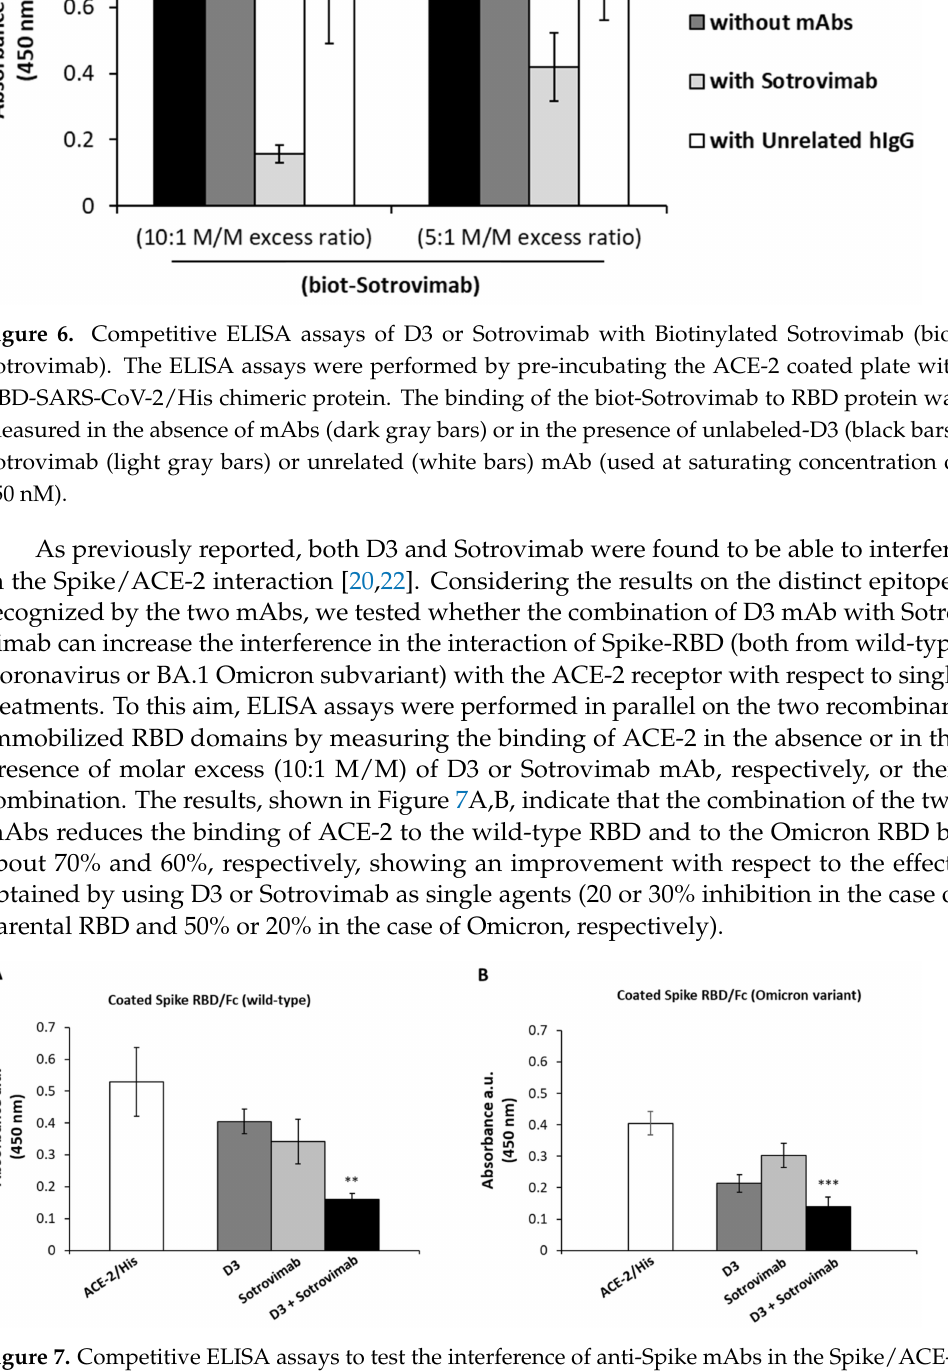
Figure 7. Competitive ELISA assays to test the interference of anti-Spike mAbs in the Spike/ACE-2 interaction. (A–B) The assays were performed by measuring the binding of ACE-2 receptor (5 nM) to recombinant wild-type ( A ) and to Omicron ( B ) Spike-RBD in the absence (white bars) or in the presence of D3 (dark gray bars) Sotrovimab (light gray bars) used alone, or their combination (black bars). The binding values were reported as the mean of at least three determinations. Error bars depicted means ± SD. P-value: *** p ≤ 0.001; ** p <